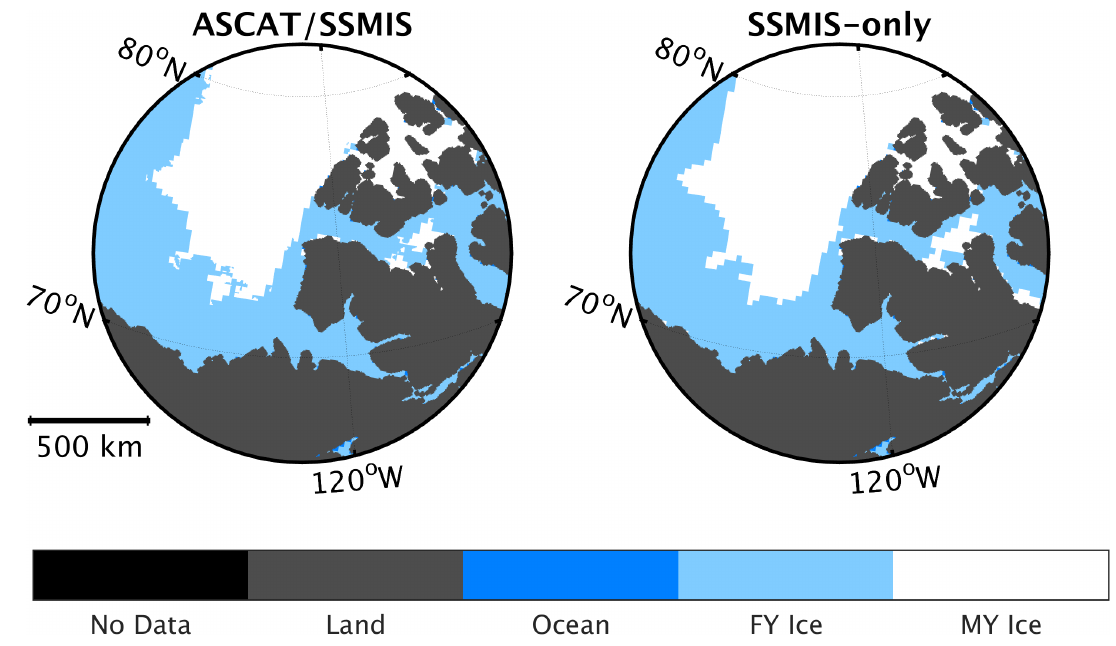
Figure 9. Zoom-in comparison of ASCAT/SSMIS and SSMIS-only ice classifications for day of year 2, 2011. In some areas, the ASCAT/SSMIS classifications contain finer details than the SSMIS classifications because of the inclusion of enhanced-resolution ASCAT